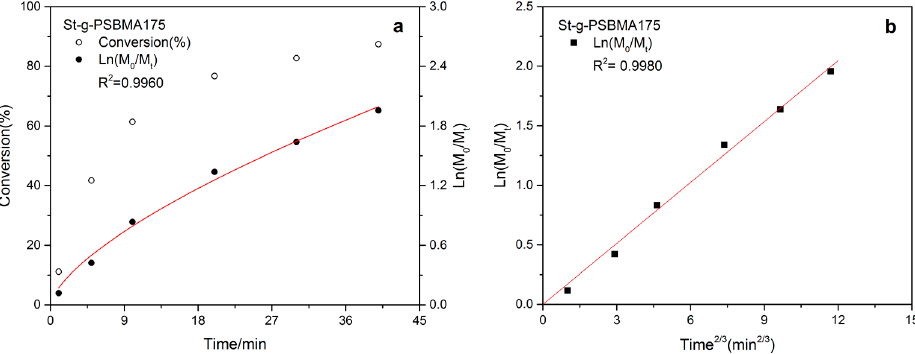
Figure 4 . Kinetic plot for the synthesis of St-g-PSBMA for target DP 200. Figure 4. Kinetic plot for the synthesis of St-g-PSBMA for target DP